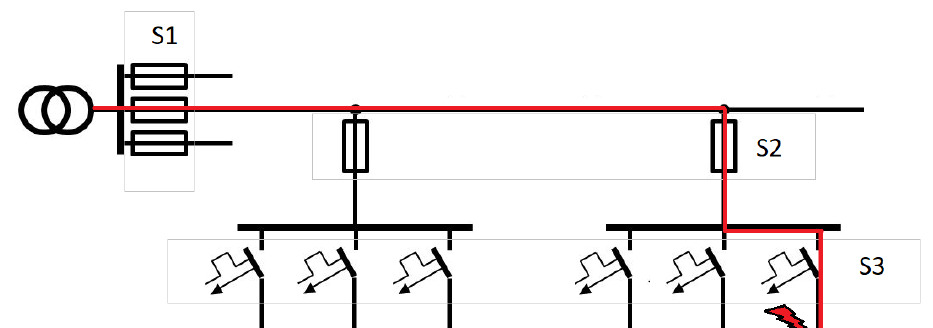
Figure 1. The diagram shows the idea of the selective operation of electrical installation protections [1].